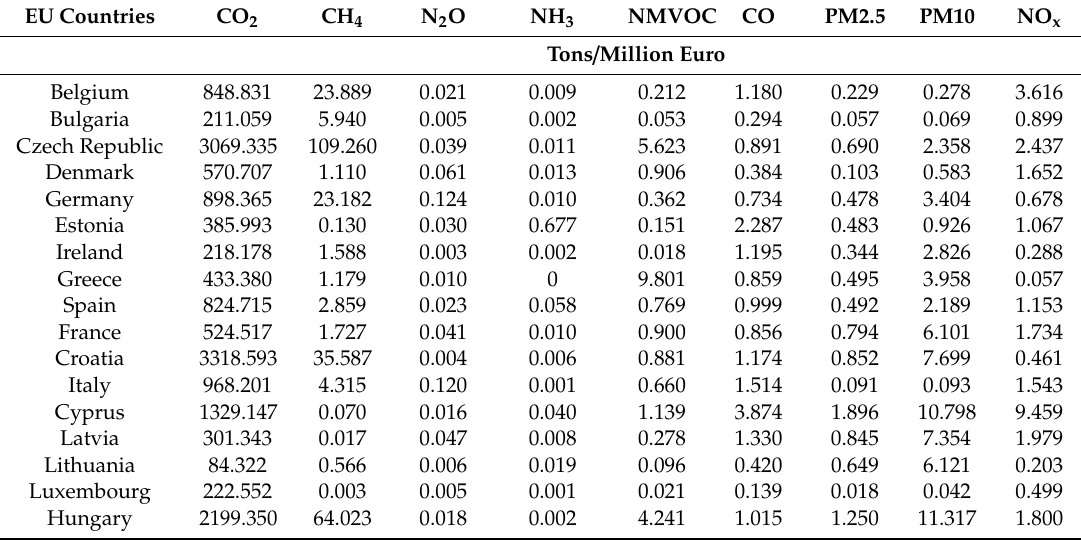
Table 2. Gas and air pollutant emissions into the atmosphere by the EU countries from the mining and quarrying sector in 2017 compared to the GVA by the mining and quarrying sector (own elaboration based on data from